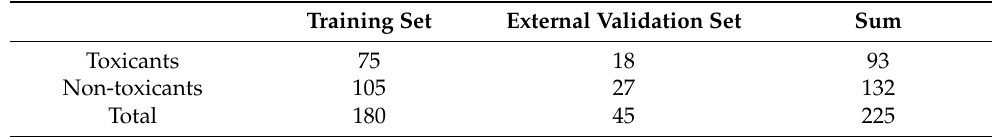
Table 1. Number of compounds in the training and external validation sets. Training Set External Validation